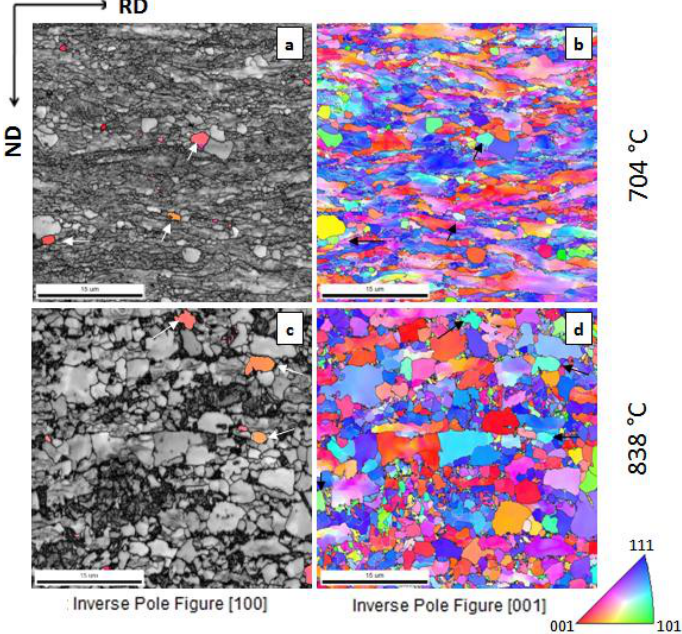
Figure 9. Microstructure of samples heated at 150 °C/s to 704 °C ( a , b ); and to 838 °C ( c , d ). The microstructure consists of a mixture of ferrite and martensite. Arrows indicate grains oriented close to the Goss {110}<001> (with a tolerance of 10°). ( c , d ). ( a , c ) correspond to IQ maps in which the recrystallized grains of ferrite are highlighted by a [100] RD Inverse Pole Figure (IPF) map. ( b , d ) are [001] ND IPF maps.